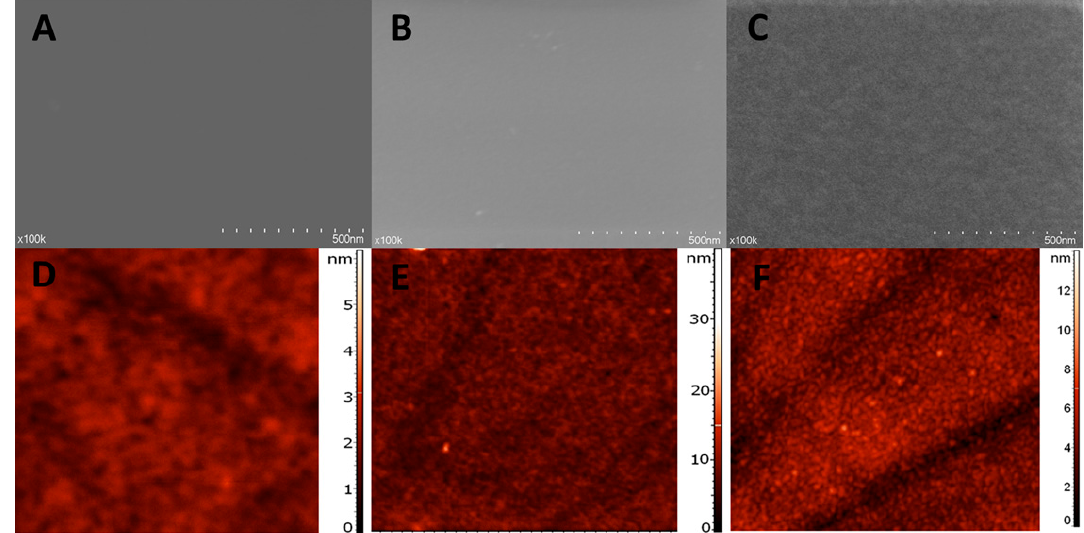
Figure 5. Surface characterization–SEM images: ( A ) NIP, ( B ) MIP and ( C ) MIP after extraction and AFM images: ( D ) NIP, ( E ) MIP and ( F ) MIP after extraction.